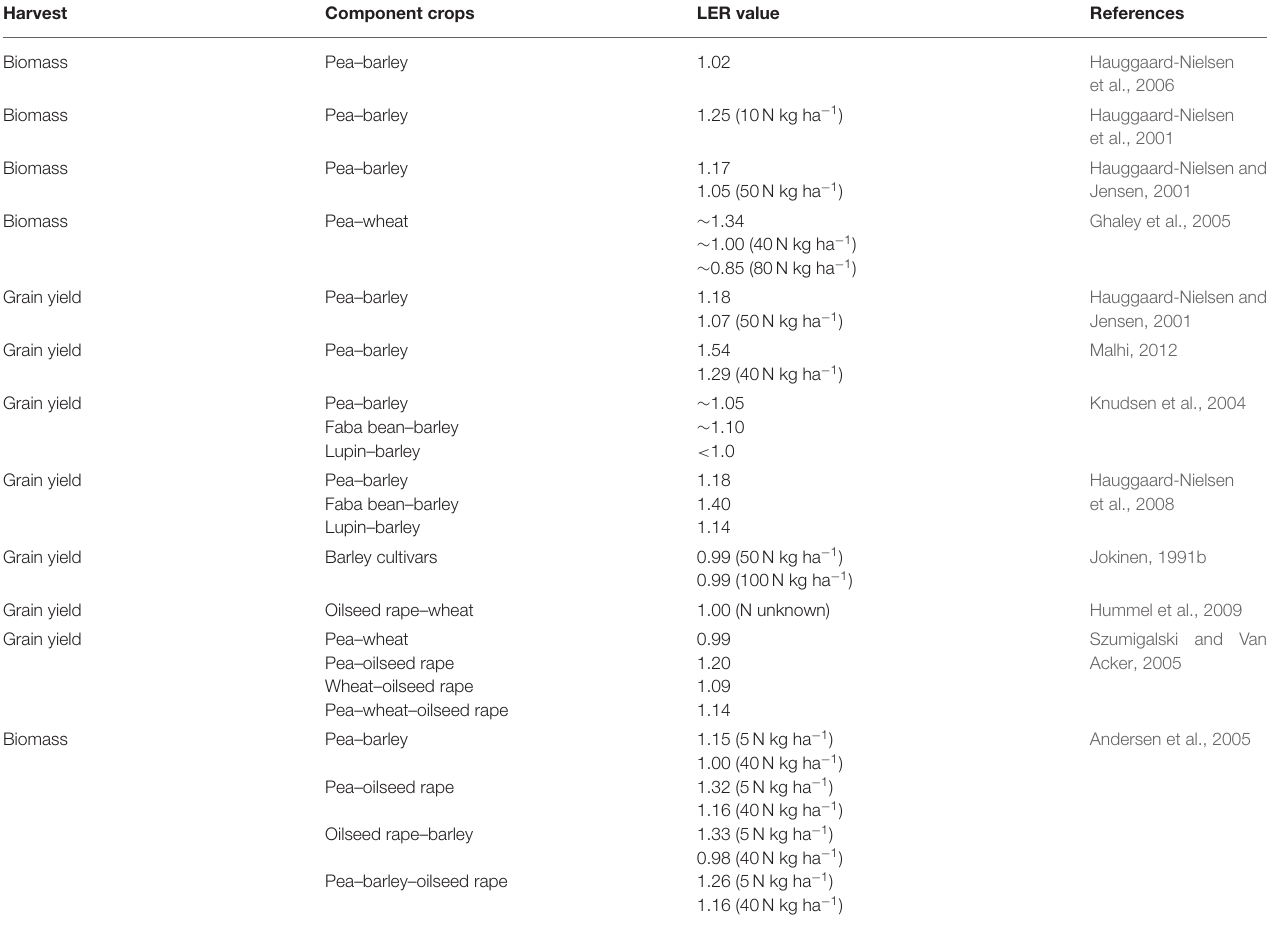
TABLE 1 | Land equivalent ratio (LER) values of different mixed spring crops grown in the boreal-nemoral region.